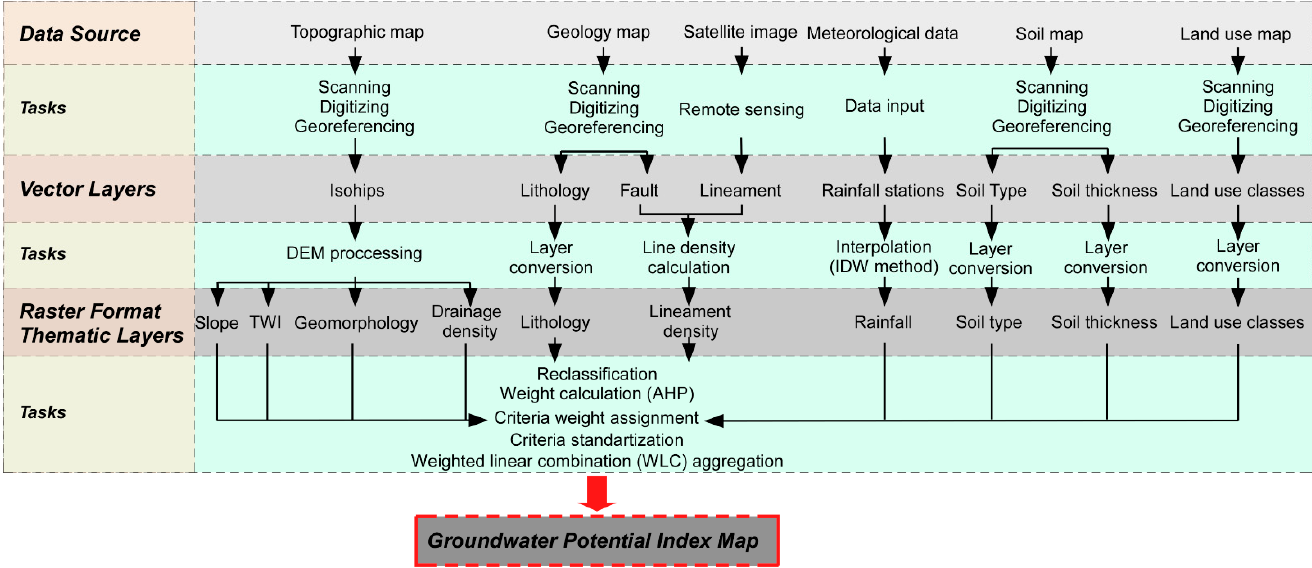
Figure 3. The methodology flow chart used to create GIS data layers and groundwater potential zones (GWPZs) map.